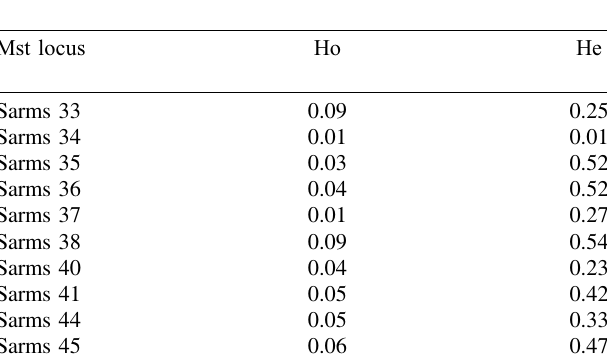
Table 3. Descriptive statistics of the Sarcoptes populations arranged by Sarms